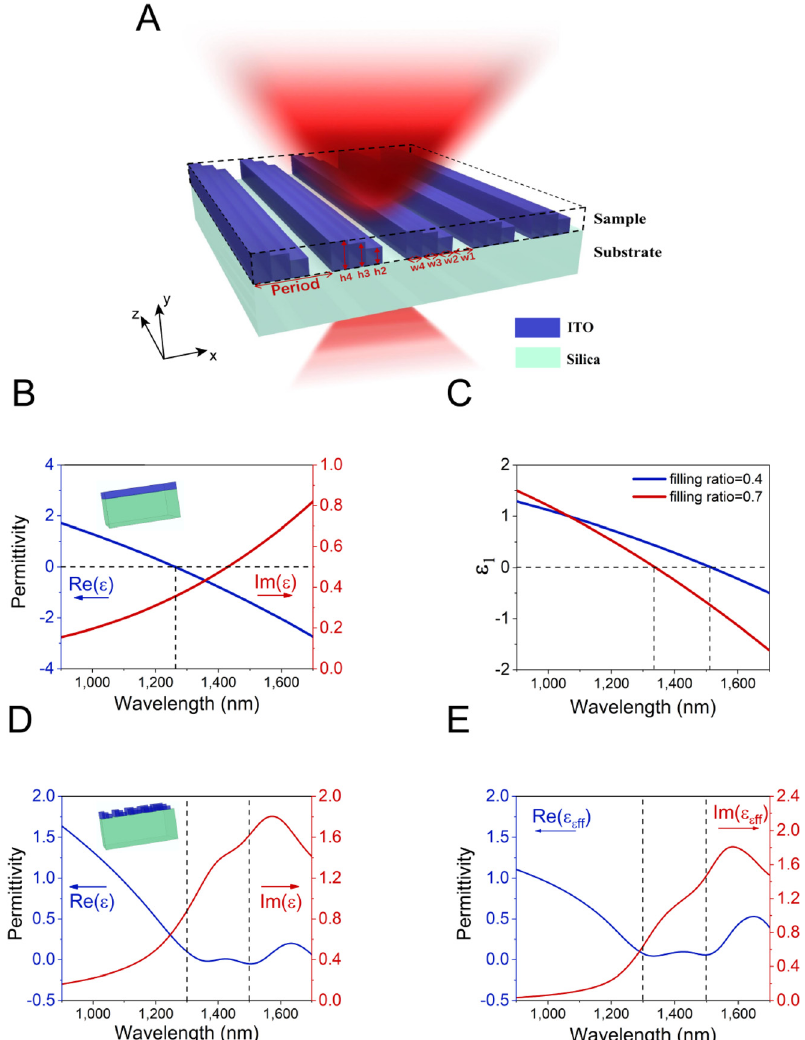
Figure 1: Optical constants of the ENZ